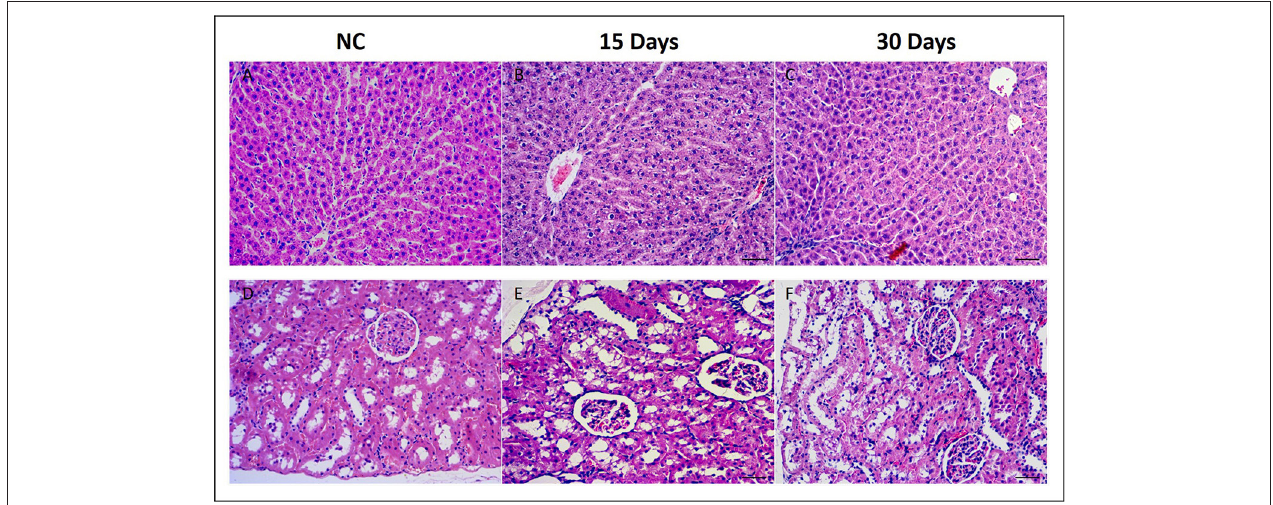
FIGURE 1 | Histopathological photomicrographs of control group (A) and high does group (B,C) liver tissues, control group (D) and high does group (E,F) kidney tissues by HE staining (10x).